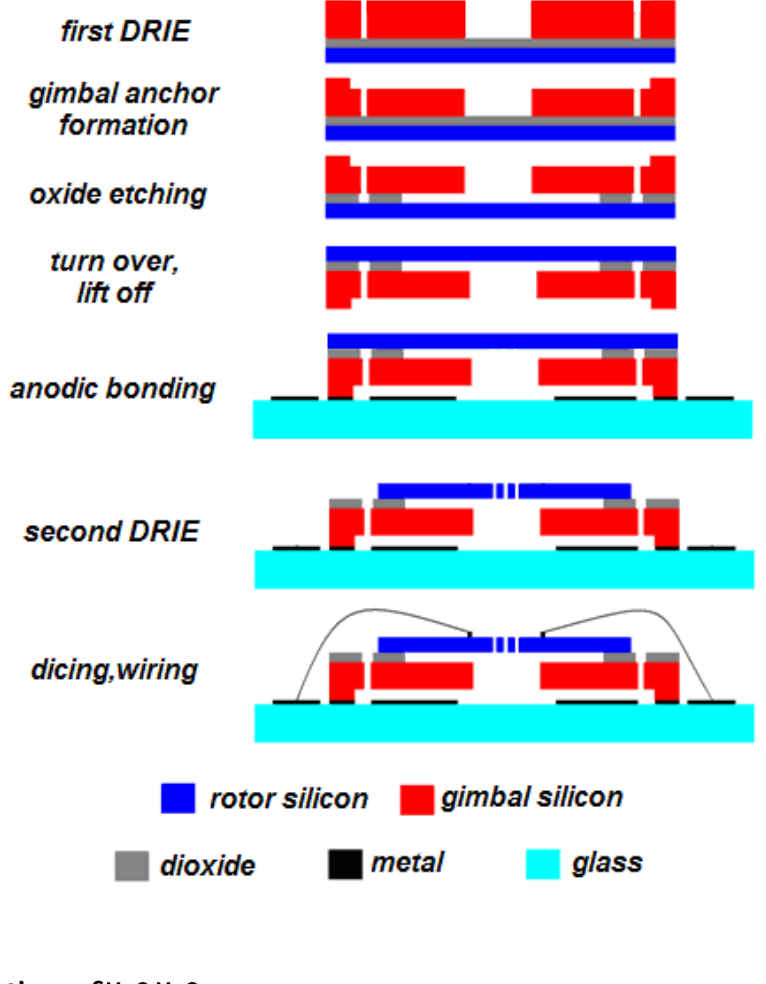
Figure 4. The proposed process flow for the